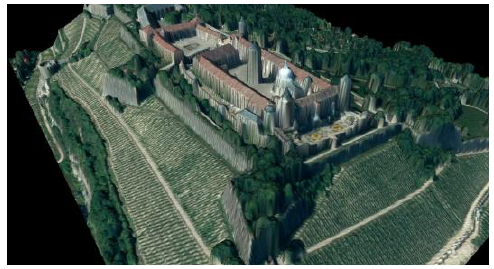
Figure 5. 2.5-dimensional surface model